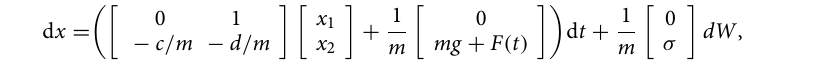
0.32m . The black curve 0.6m and the damping ratio to D ≃ =